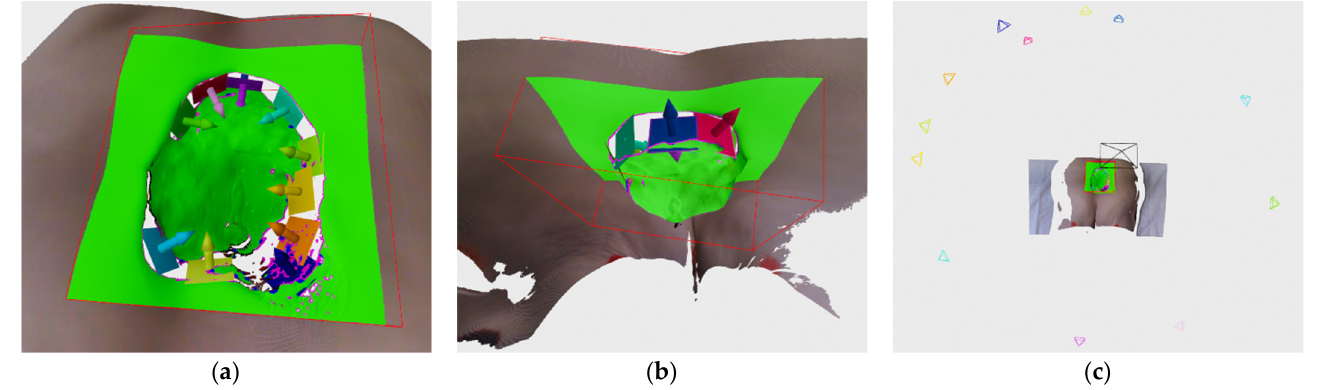
Figure 10. ( a ) DPlanes generated based on edge points represented by differently colored planes and normals; ( b ) duplicate DPlanes because of the plane orientation w.r.t. recording orientation; ( c ) DPlane hypothesis represented by different color cones, while black cone is the current recording pose.